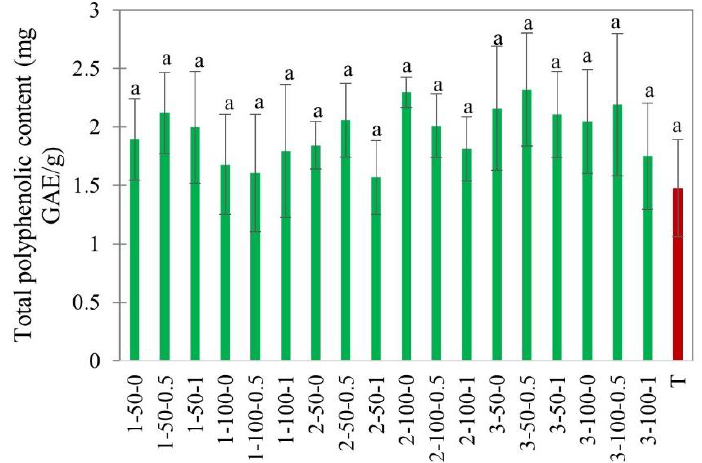
Figure 13. Total polyphenolic content of EHD (marked in green and labeled as thickness-slice load density-airflow) and hot air-dried (marked in red as T) apple slices. Different lower-case letters indicate statistically significant differences ( p < 0.05). Table 3. The p -values obtained from the multifactorial ANOVA using the general linear model at a 0.05 significance level for quality